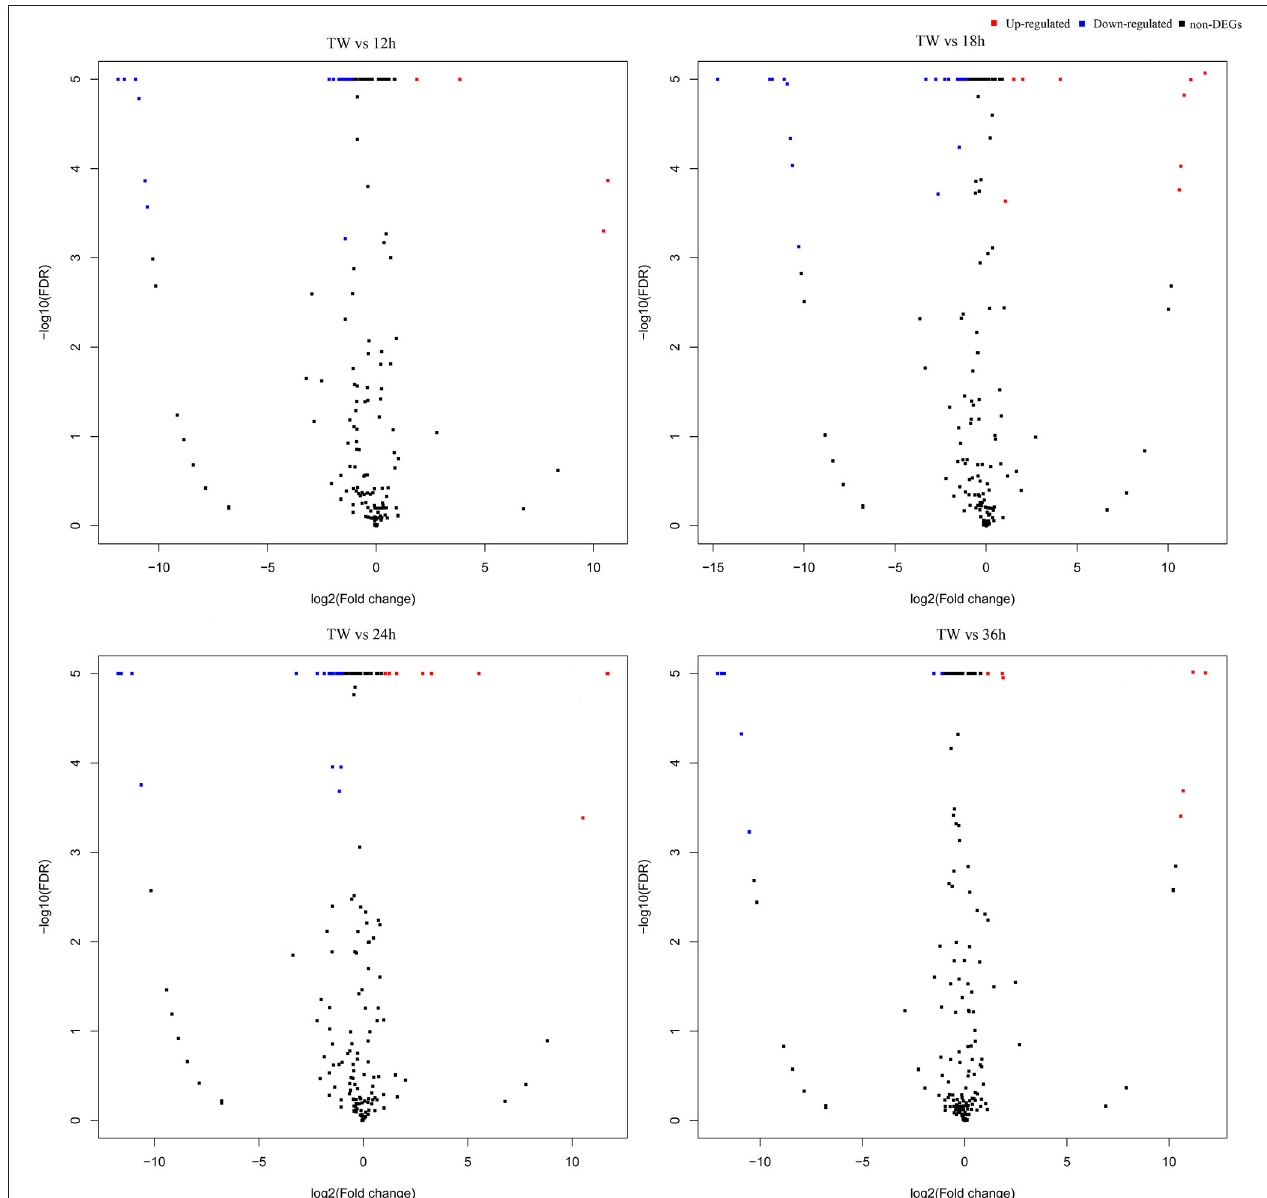
FIGURE 2 | Volcano plot of differentially expressed microRNAs in Plutella xylostella post-infection. The volcano plots represent differentially expressed miRNAs at different time points (12, 18, 24, and 36h) post-infection compared to control.